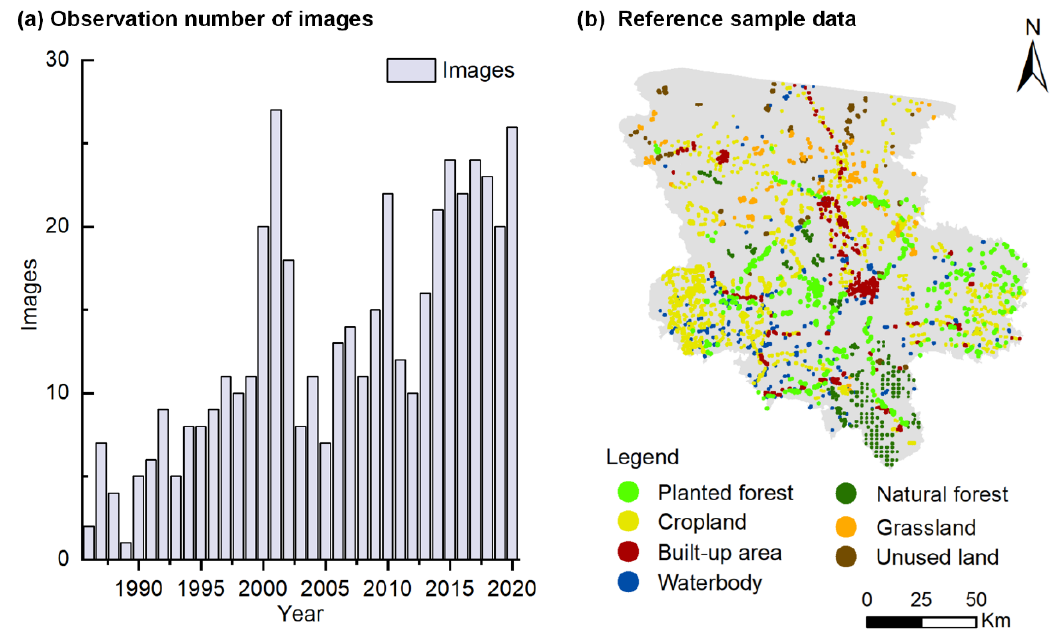
Figure 3. Observation number of images per year in the study area ( a ), and ( b ) spatial distribution of the reference sample data in the study